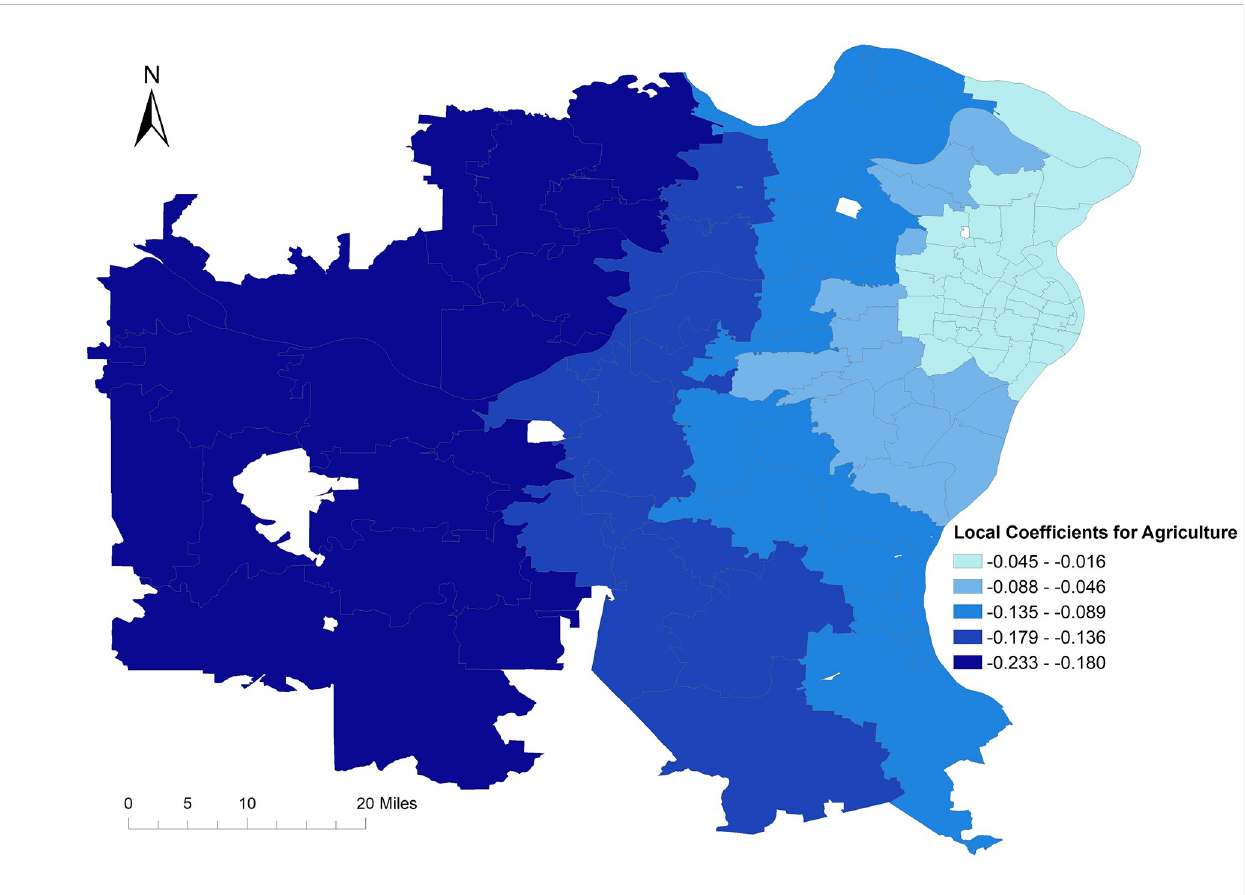
Fig 2. Geographically varying coefficients of local geographically weighted negative binomial model of COVID-19 risks in the Greater St. Louis Area, Missouri